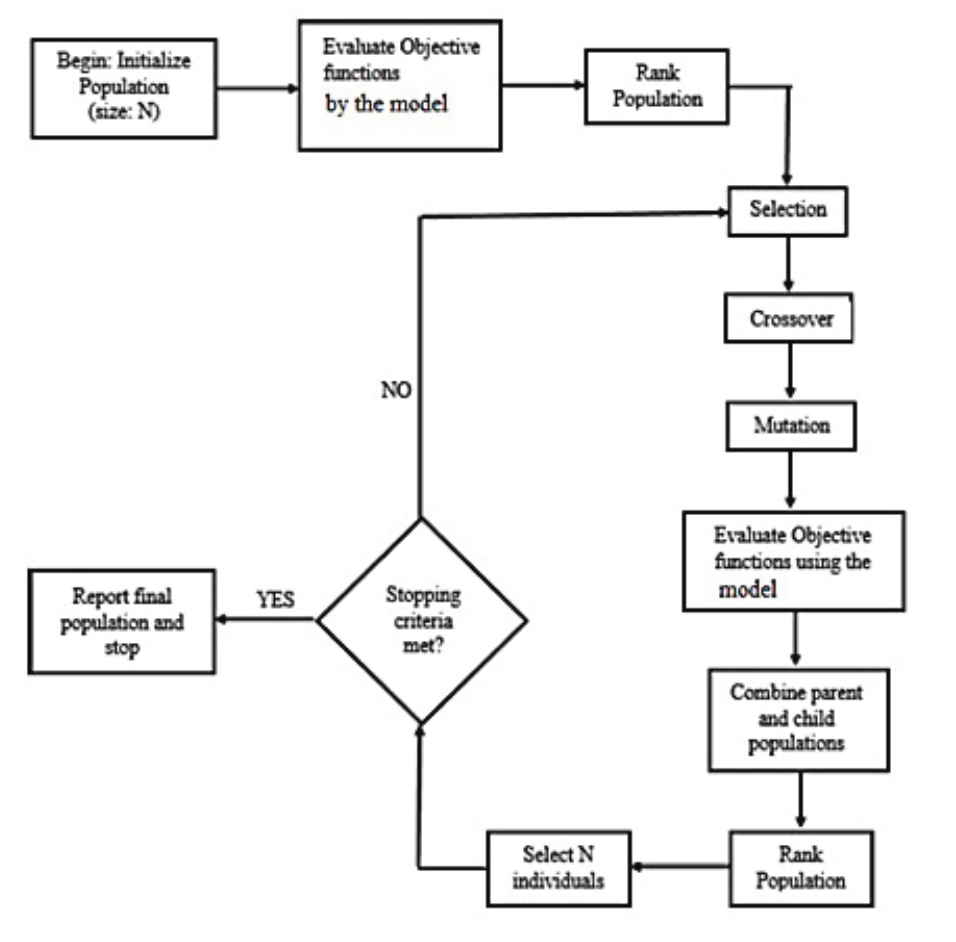
Fig. 2 – Calculation work flow chart of NSGA